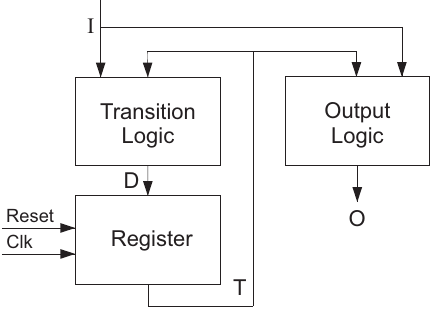
Figure 2. Structural diagram of P Mealy